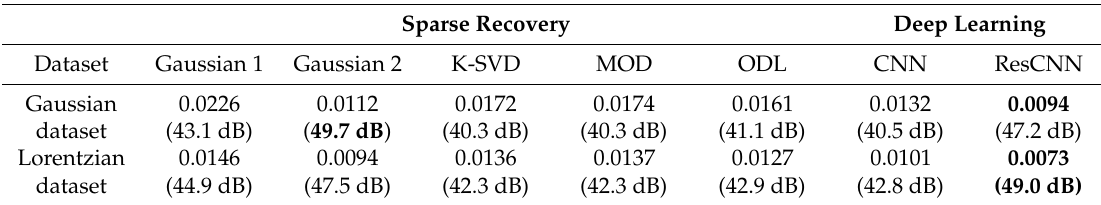
Table 2. Average root mean squared errors (RMSEs) and peak signal to noise ratios (PSNRs) over synthetic